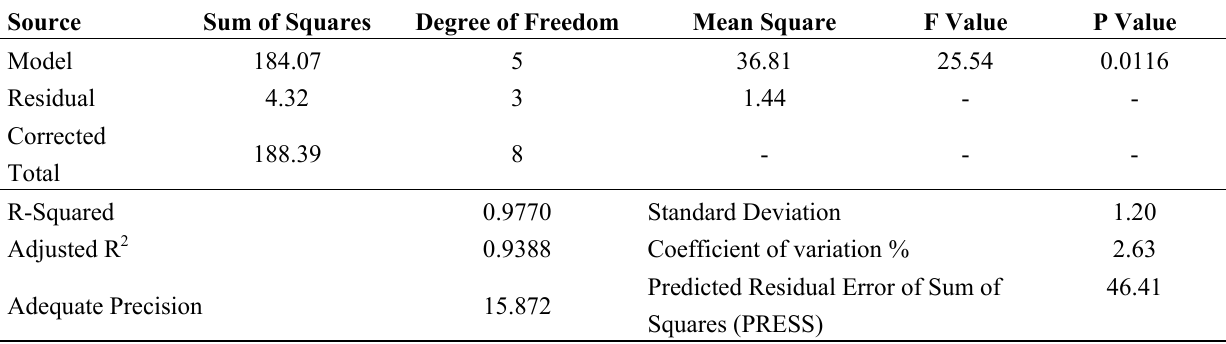
Table 3. Analysis of Variance (ANOVA) and statistical parameters of TEA-based esterquat cationic surfactant reaction (Linear